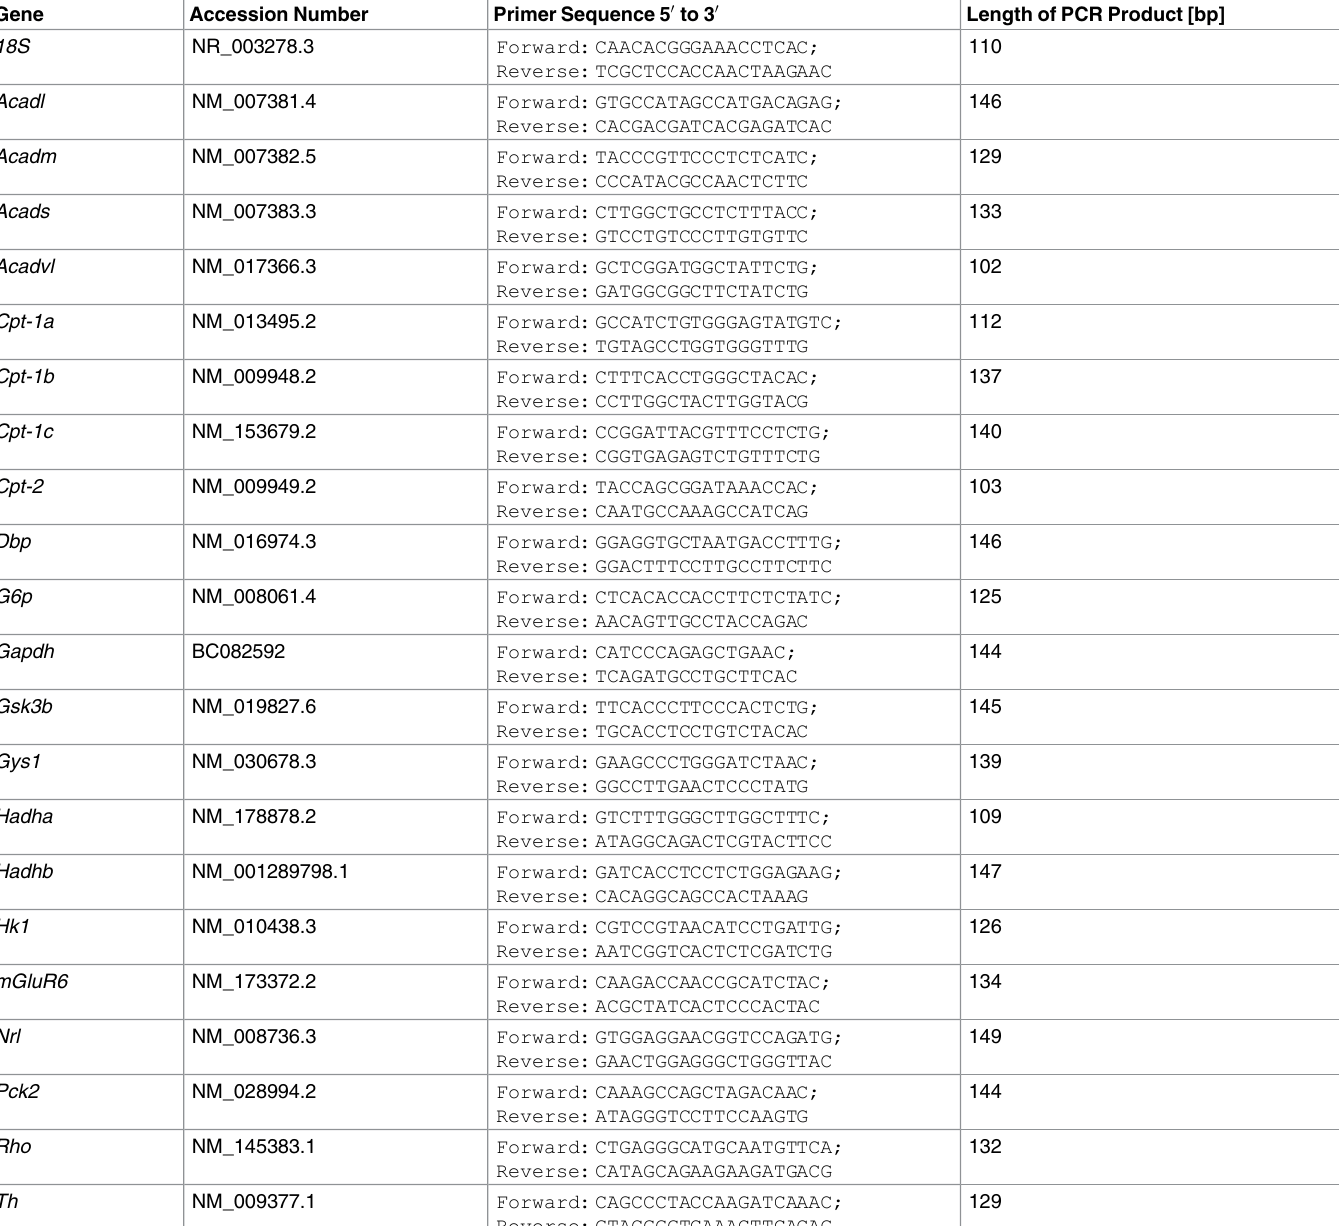
Table 1. Primer sequences used for